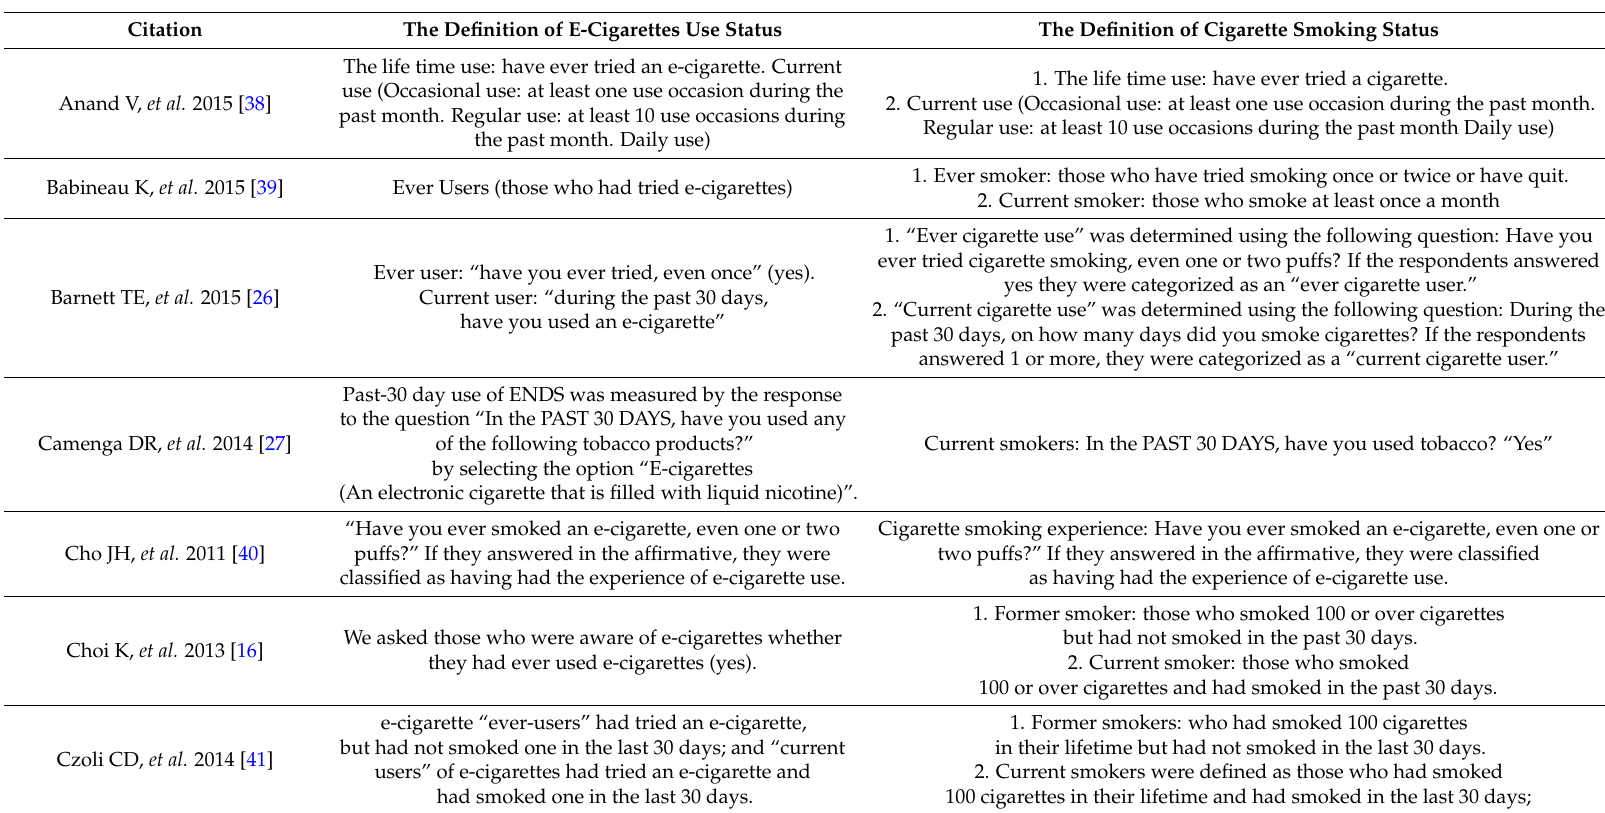
Table A1. Definition of the e-cigarettes and cigarettes smoking status in studies included in the